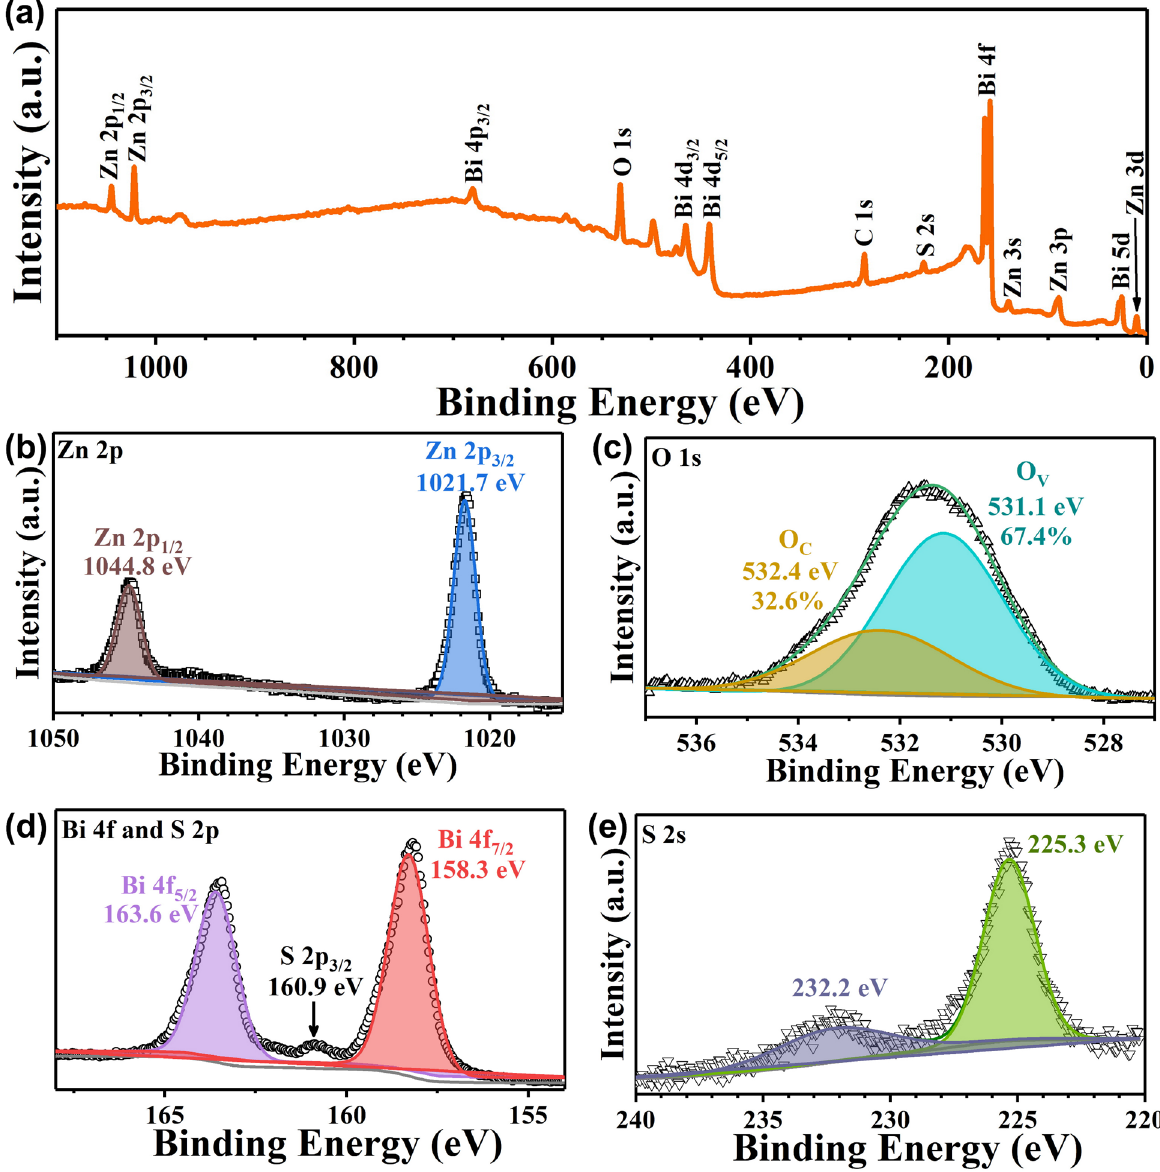
Figure 4. ( a ) XPS survey spectrum, and high ‐ resolution ( b ) Zn 2p, ( c ) O 1s, ( d ) Bi 4f, and ( e ) S 2s spectra of the ZnO/Bi 2 S 3 photoanode.